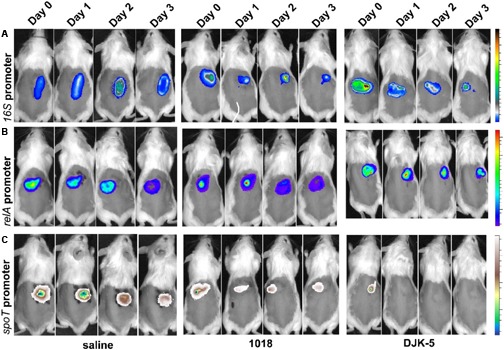
In vivo tracking of P. aeruginosa PAO1 16S, relA, and spoT promoter activity. The infection progress was monitored at the indicated time points. Female CD-1 mice were injected with a high bacterial number (5 × 107 CFU PAO1) and treated with either saline (control, left panel) or peptides 1018 (middle panel) and DJK-5 (right panel) 1 h post-infection. (A)
16S promoter activity as induction/suppression control for peptide treatment. Radiance color scale from 0.5 to 2.5 × 109. (B)
relA promoter activity. Radiance color scale from 0.5 to 4.5 × 107. (C)
spoT promoter activity. Radiance color scale from 0.5 to 4.5 × 107. (A–C) All experiments were done at least twice with three mice/group.